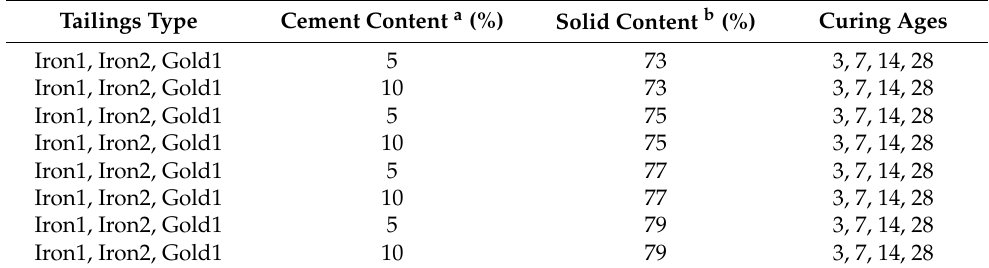
Table 3. Mixing ratios of all CTB